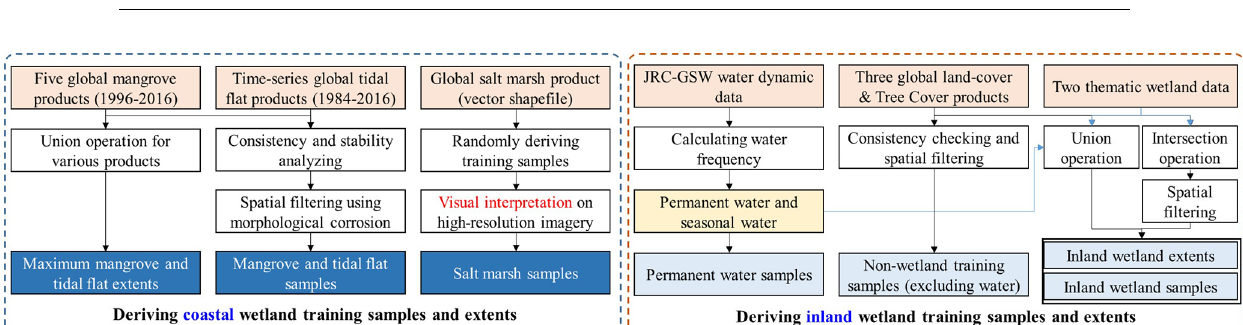
Figure 2. The flowchart of deriving coastal and inland wetland samples from multiple pre-existing datasets.